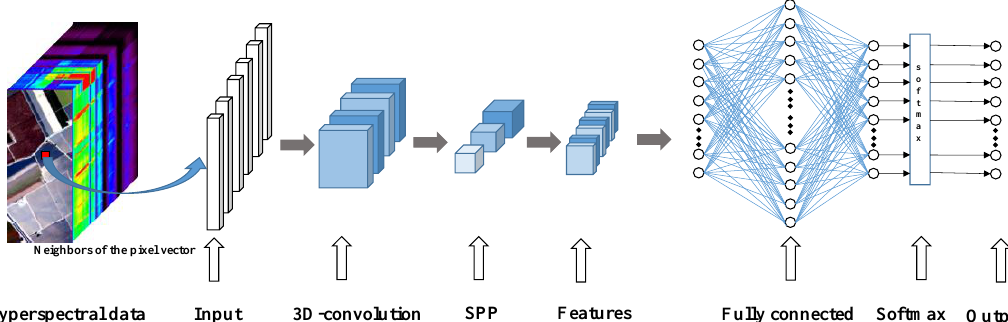
Figure 2. Flowchart of our proposed deep CNN